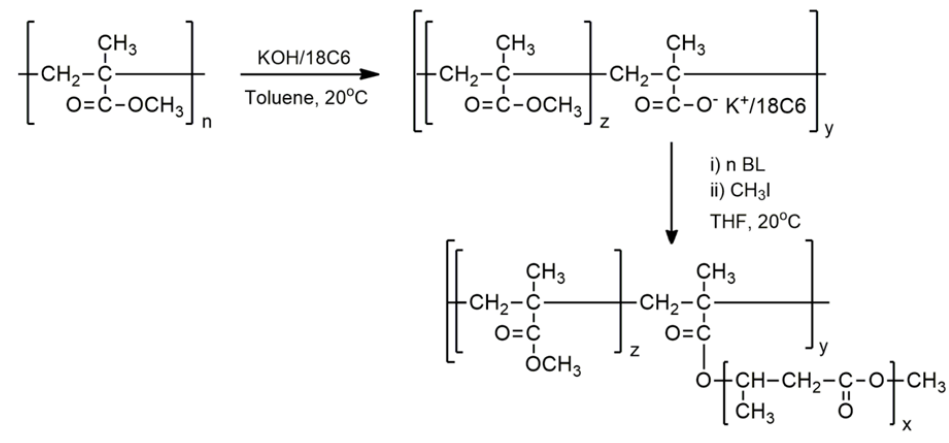
Scheme 5. Synthesis of graft copolymers of PMMA with poly(BBL) side